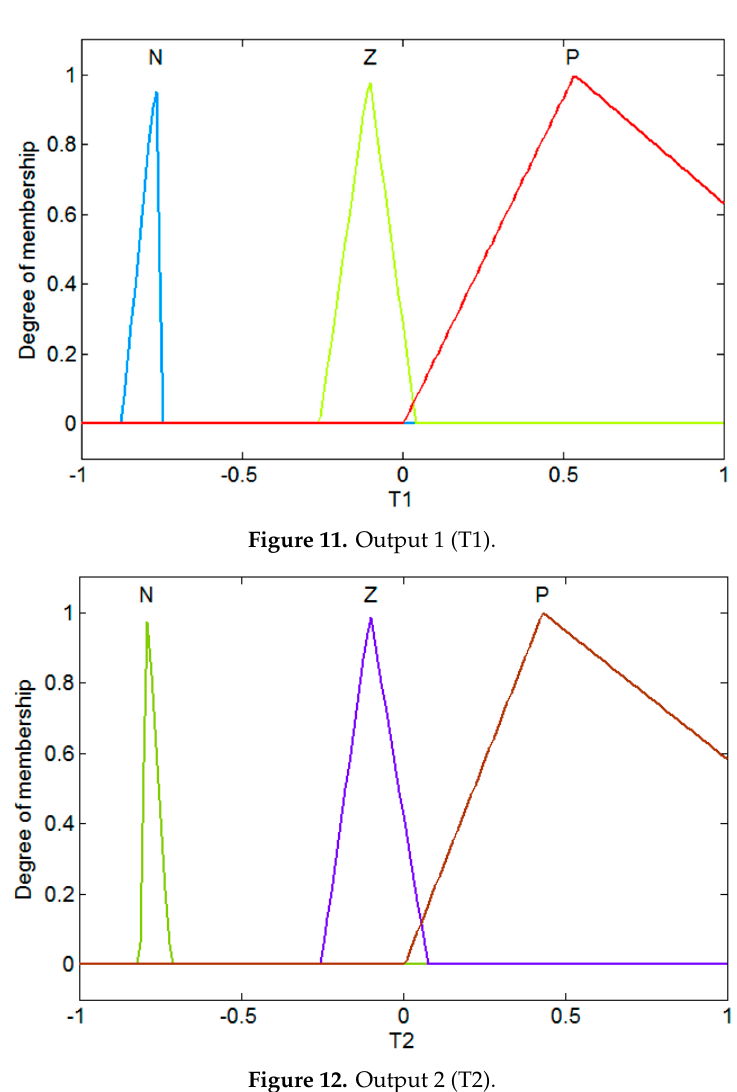
Figure 12. Output 2 (T2).